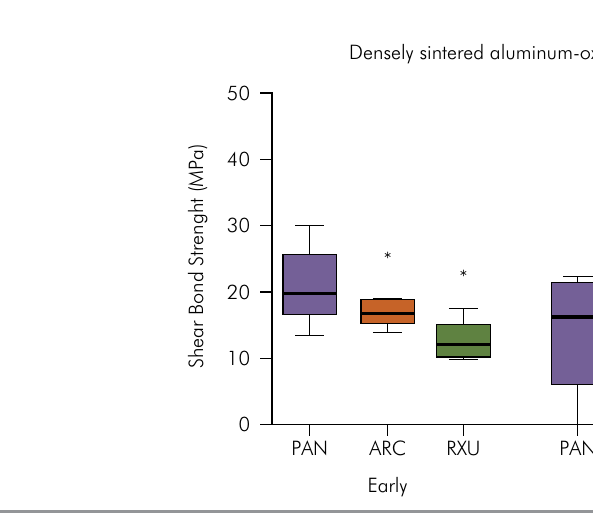
Figure 3. Boxplots of early and late shear bond strength of resin cements to densely sintered aluminum-oxide ceramic.